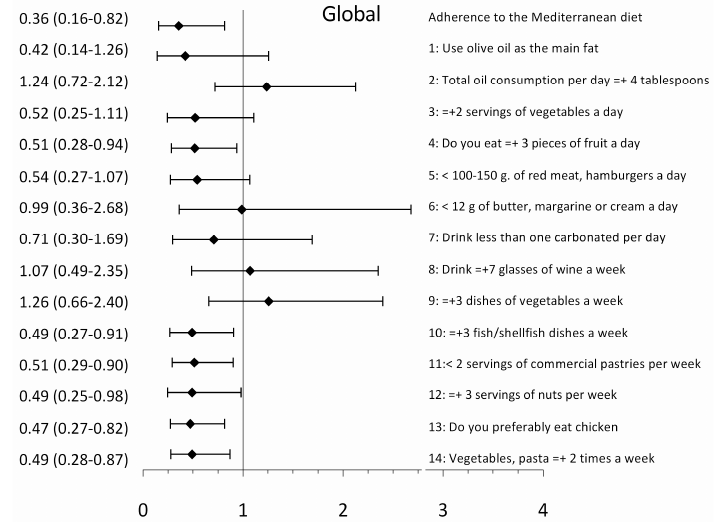
Figure 2. Bars show OR (odds ratio) and 95% CI. Association between arterial aging and adherence to the Mediterranean diet and its components. Dependent variable: the presence of early vascular aging (EVA) versus normal vascular aging (NVA) (1 = EVA, 0 = NVA). Independent variables: adherence to the Mediterranean diet and each of its components (1 = Yes, 0 = No). 1, For cooking, do you use olive oil as the main fat? 2, Does the total oil consumption per day ≥ 4 tablespoons? 3, Do you eat ≥ 2 servings of vegetables a day? 4, Do you eat ≥ 3 pieces of fruit a day (including natural juice)? 5, Do you eat < 100-150 g of red meat, hamburgers, sausages a day? 6, Do you eat < 12 g of butter, margarine or cream a day? 7, Do you drink less than one carbonated and / or sugary drink (soft drinks, colas, tonics, bitter) per day? 8, Do you drink ≥ 7 glasses of wine (100 ml) a week? 9, Do you eat ≥ 3 dishes of vegetables a week? (1 dish or serving of 150 g) 10, Do you eat ≥ 3 fish / shellfish dishes a week? (1 piece, dish or portion: 100–150 g of fish or 4-5 pieces or 200 g of seafood). 11, Do you eat < 2 servings of